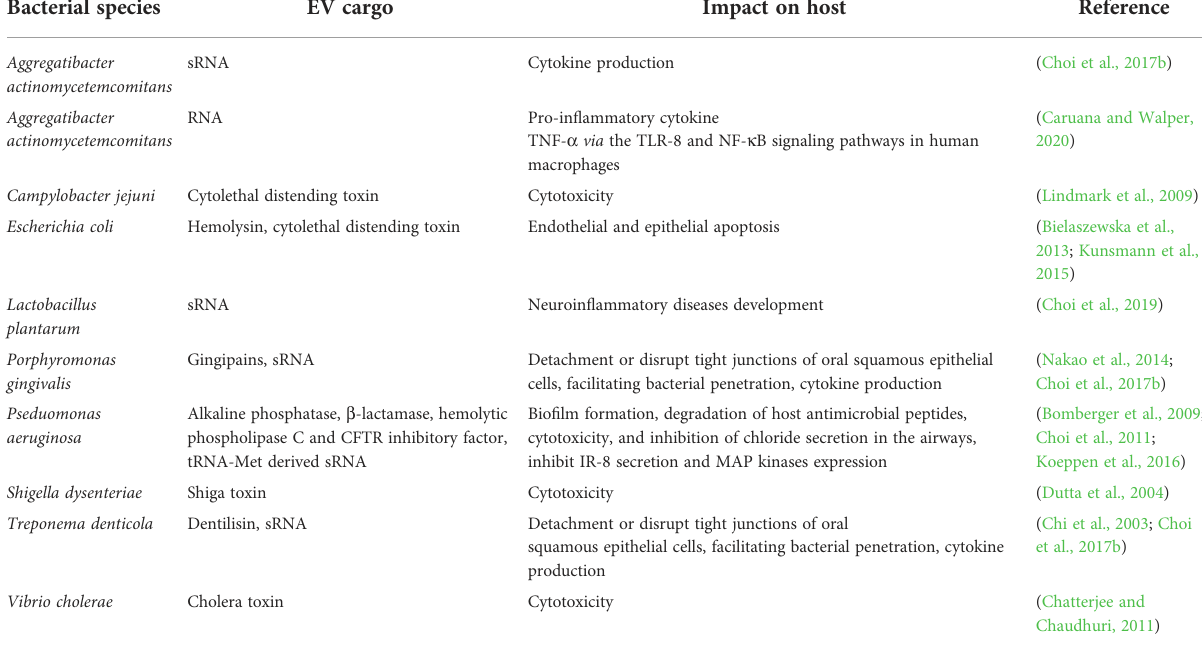
TABLE 3 The impact of different EV cargoes on host bacteria. Bacterial species